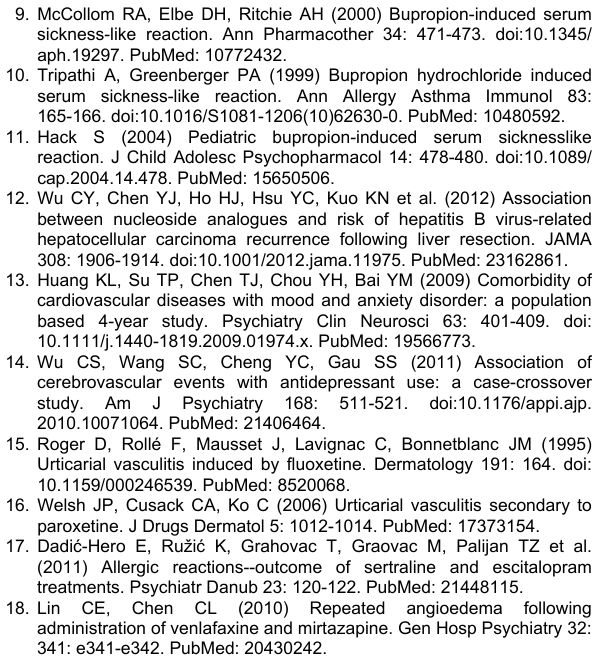
Table S3. Comparisons of early and delayed onset dermatologist-diagnosed urticaria